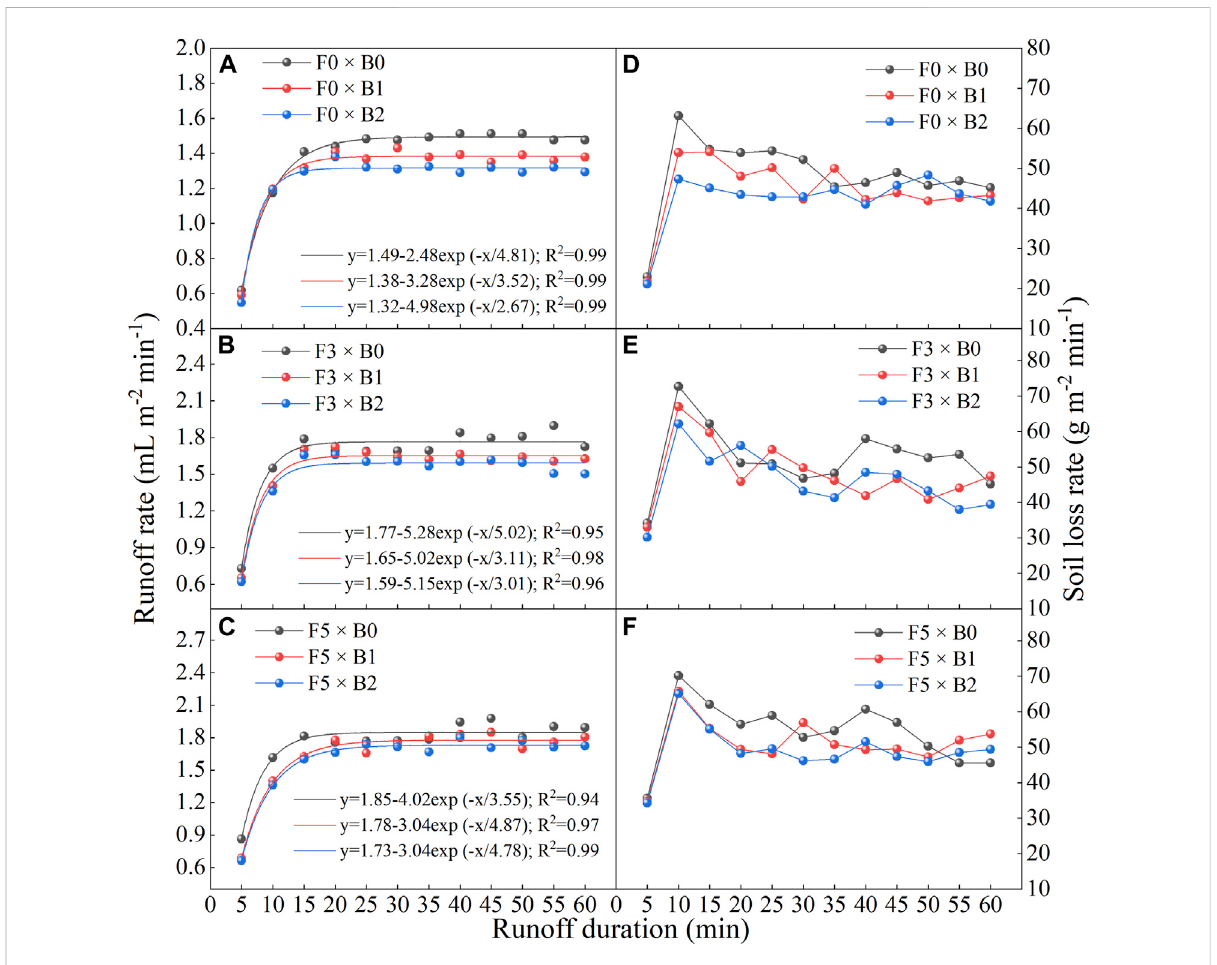
FIGURE 2 In fl uence of biochar application rates (B0: 0 kg hm − 2 , B1: 500 kg hm − 2 , and B2: 1,000 kg hm − 2 ), on (A – C) runoff rate and (D – F) soil loss rate under the freeze-thaw conditions (F0: 0 cycle, F3: 3 cycles, and F5: 5 cycles).